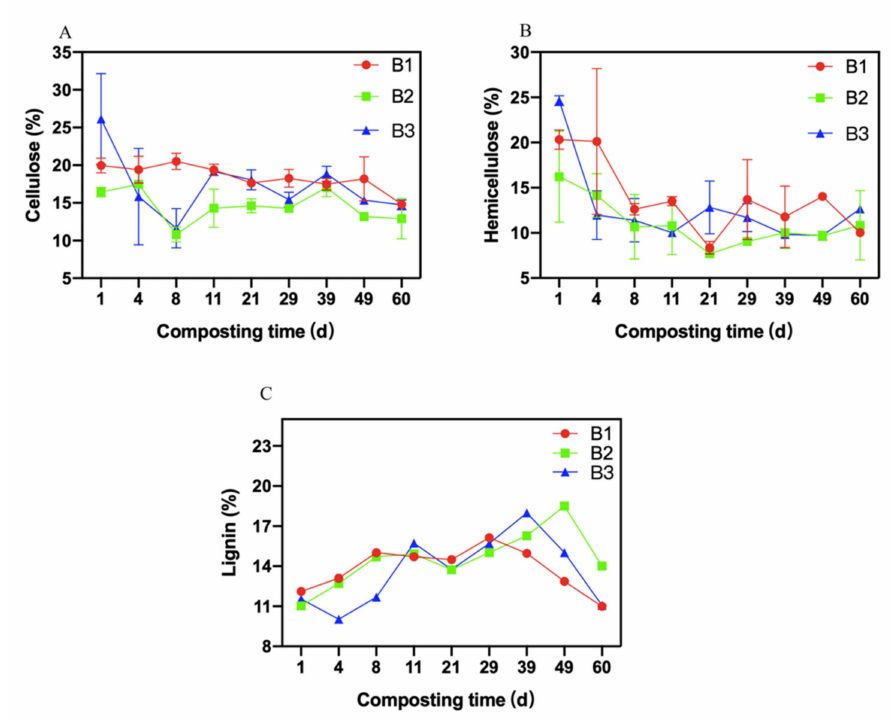
Figure 4. Variation in fiber. ( A ): Variation in the cellulose content; ( B ): Variation in the hemicellulose content; ( C ): Variation in the lignin content. Error bars represent standard deviations of measurements (n =